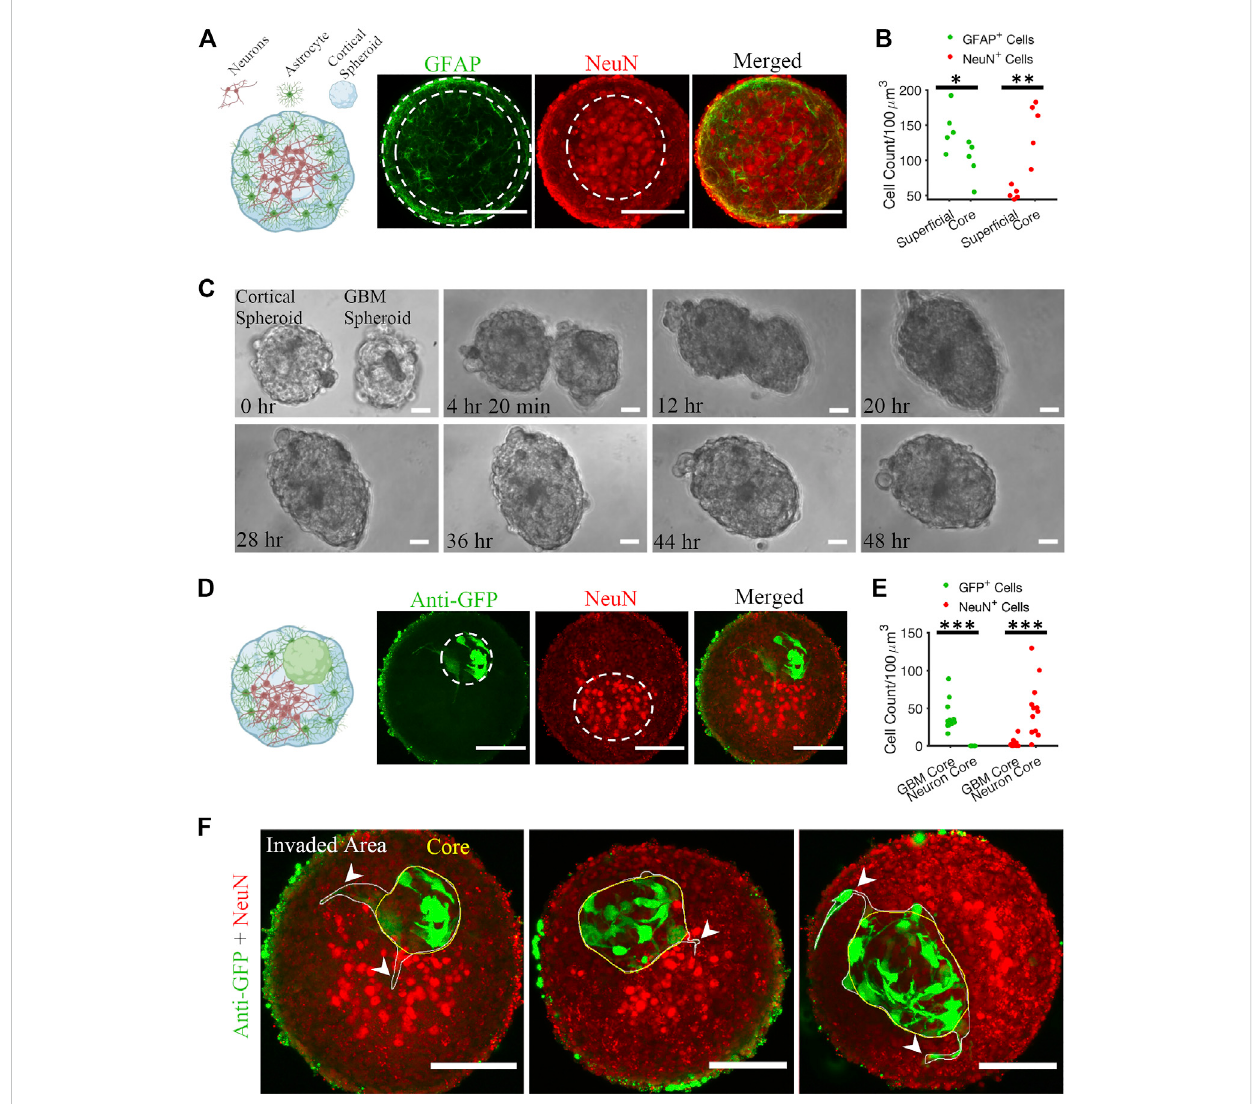
FIGURE 2 Matrix-free co-culture of a cortical spheroid and GBM spheroid. (A) Left: schematic of the internal morphology of a cortical spheroid. Right: representativez-projectionofanti-GFAP and anti-NeuN stained fl uorescentimages shows aneuronal core inthecenter andastrocytes inthesuper fi cial layer. (B) Comparison of GFAP + and NeuN + cell count in core and super fi cial layer, n = 5 spheroids. (C) Time-lapse imaging of merging GBM and cortical spheroids. (D) Left: schematic of the internal morphology of a merged cortical-GBM spheroid. Right: representative fl uorescent images of cortical- GBM spheroid stained with anti-GFP (GBM cells expressed GFP) and anti-NeuN antibodies. The cluster of GBM cells pushed the neuronal core to an off- center position. (E) Comparison of GFP + and NeuN + cell count in core and super fi cial layer, n = 12 spheroids. (F) Three examples of invasion of GBM spheroids in matrix-free co-culture (merged cortical-GBM spheroid). Arrowheads show invasive protrusions. Scale bar = 100 μ m in all panels. Two- sample Kolmogorov – Smirnov (KS) test was used to measure statistical signi fi cance. * p < 0.05, ** p < 0.01 and *** p <